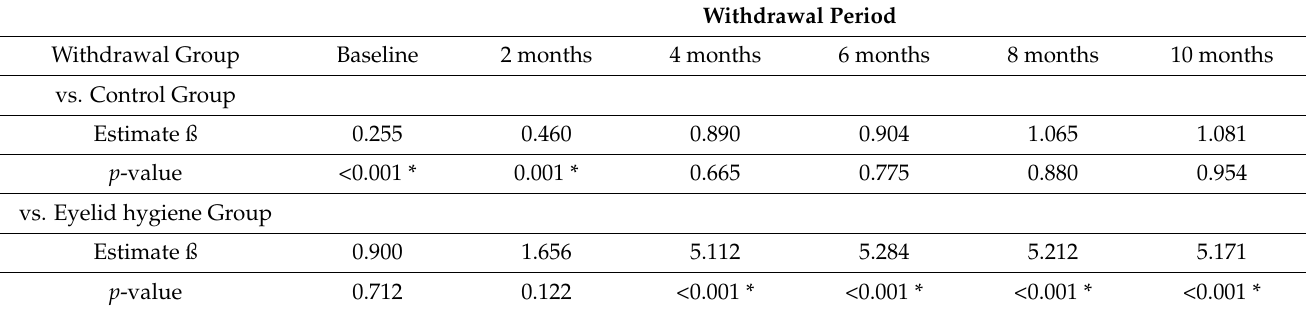
Table 4. Impact of discontinuity of eyelid hygiene on meibomian gland dysfunction by withdrawal period.